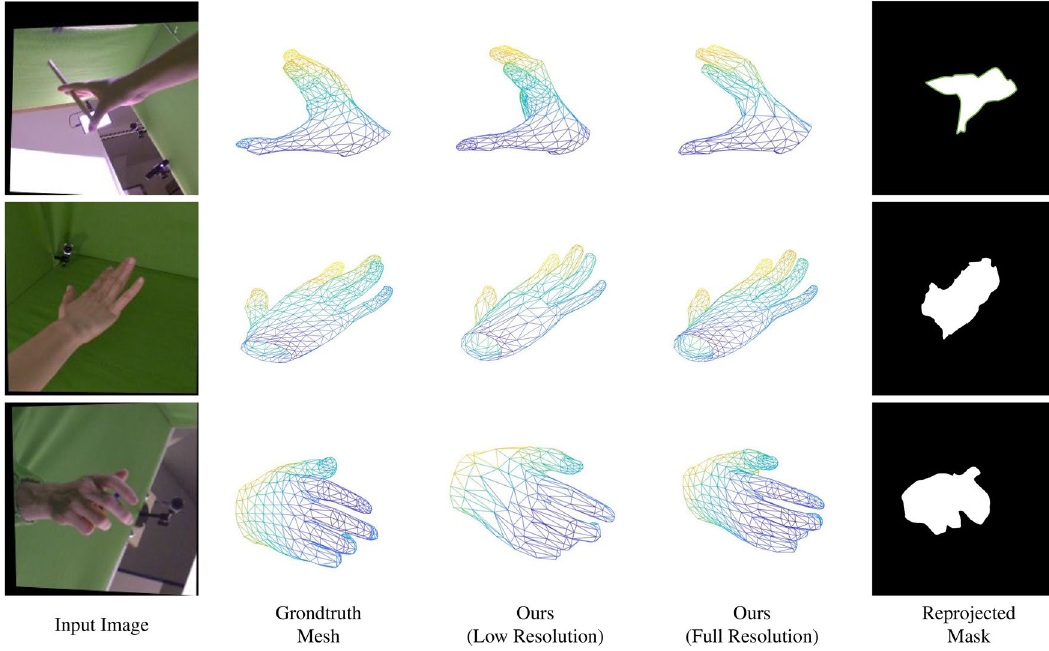
Figure 7. The qualitative results obtained for the FreiHand dataset 16 . The meshes in the FreiHAND dataset is based on MANO model 5 and thus contains 778 vertices.